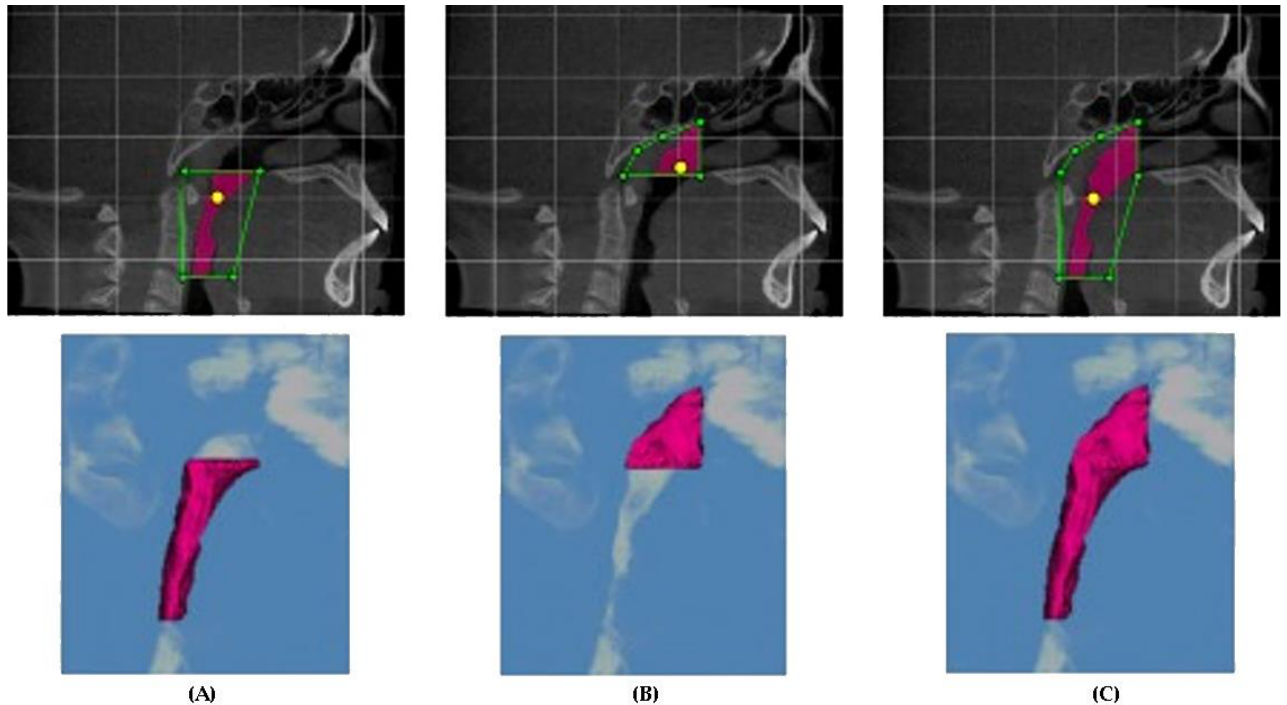
Figure 2. Showing boundaries of airway segmentation performed in Dolphin Imaging for ( A ) oropharynx, ( B ) nasopharynx, and ( C ) total upper airway.